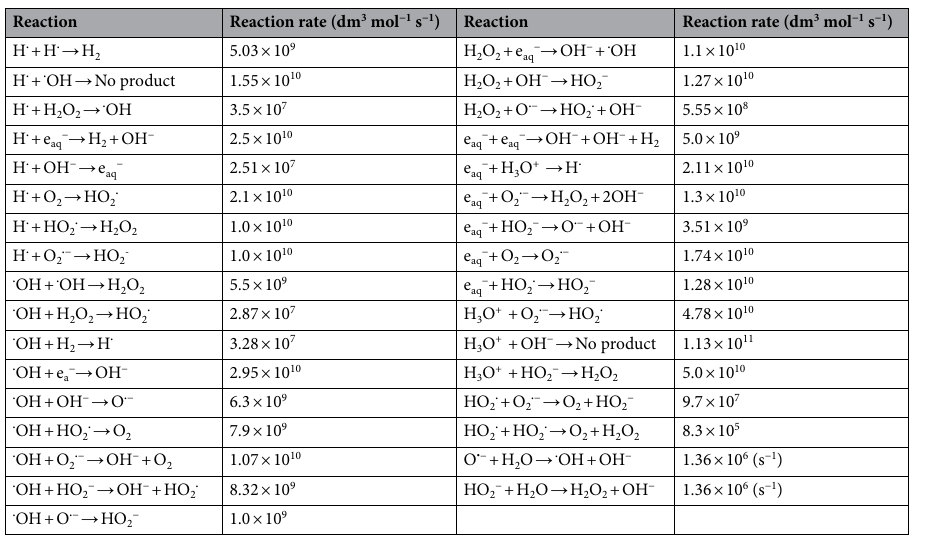
Table 3. Reaction and reaction rate constants. These values are based on the data of Hatano et al. 34 . The reaction rate constants for first-order reactions of species O ・ − , HO 2 − are based on the data reported by Plate 35